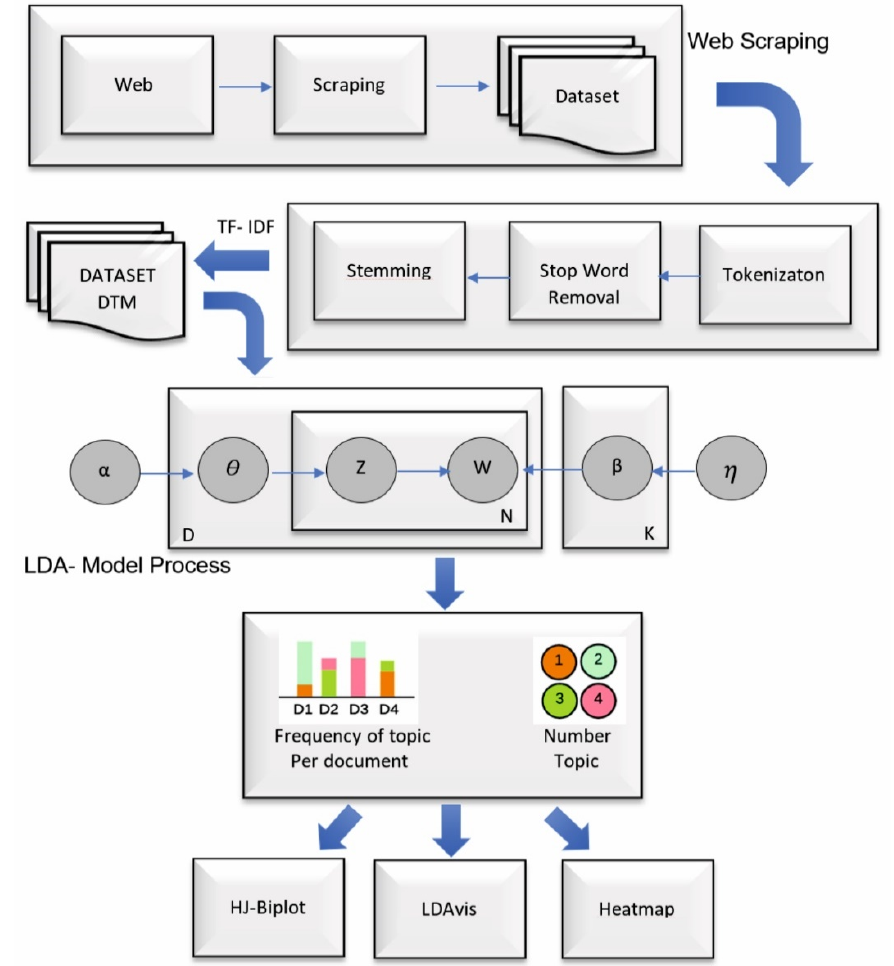
Figure 1. Applied methodology architecture.